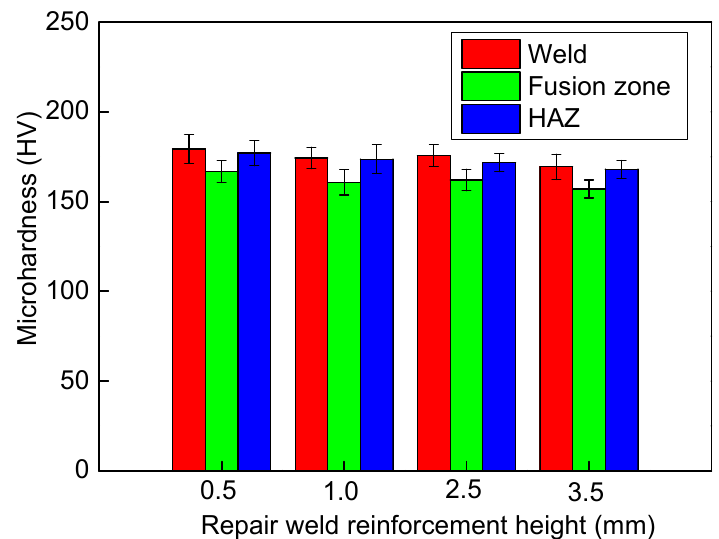
Figure 10. E ff ect of repair welding height on the microhardness. Figure 10. Effect of repair welding height on the microhardness. Figure 10. Effect of repair welding height on the microhardness.